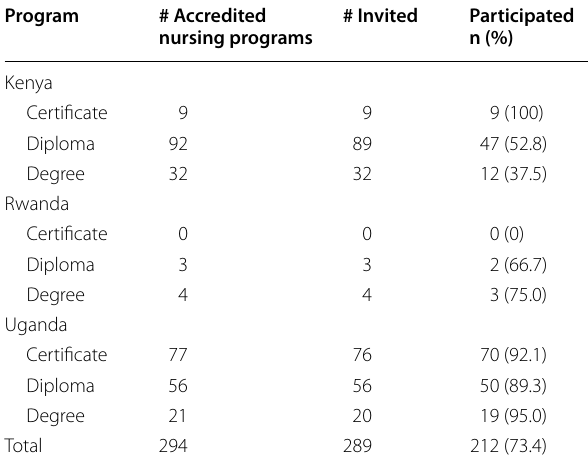
Table 1 Accredited post-secondary programs in human nursing across Kenya, Rwanda and